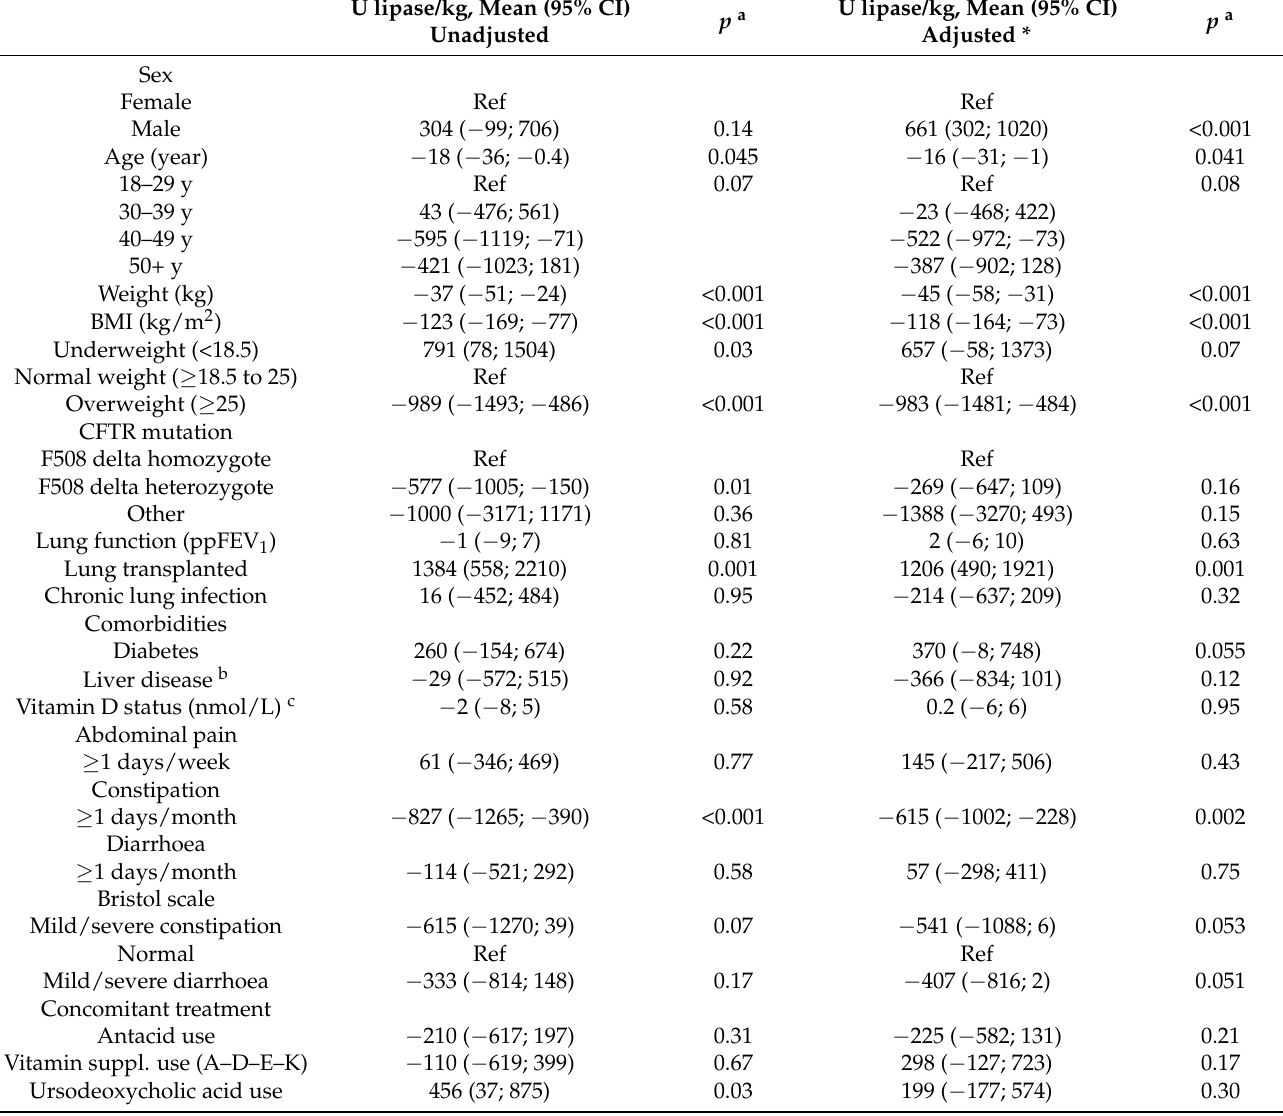
Table 4. Correlates of PERT intake per main meal in 120 adults with cystic